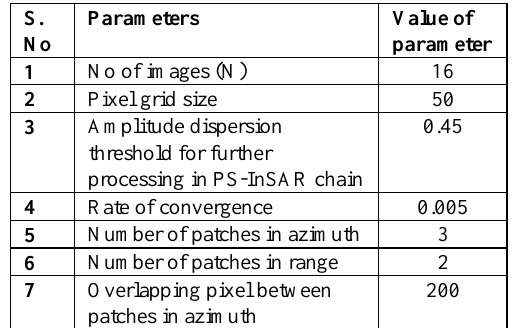
Fig. 3. Interferograms generated for SBAS processing.